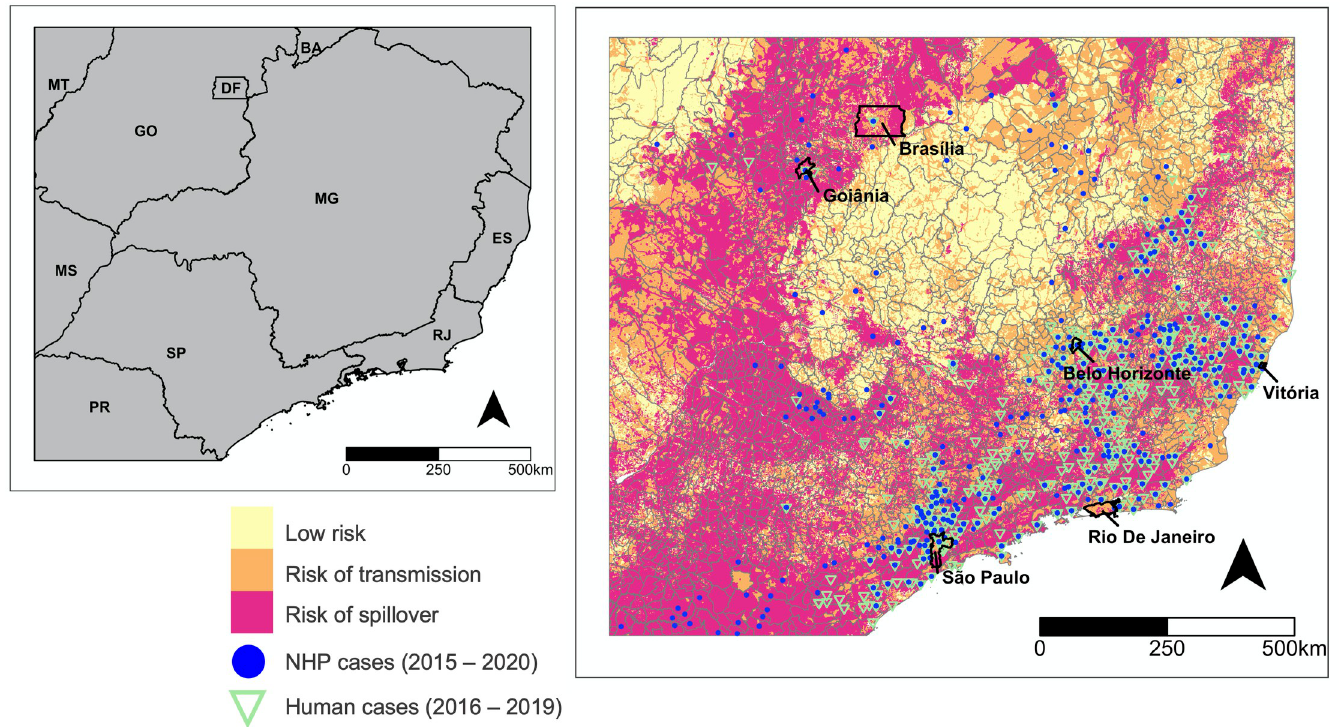
Fig 5. Risk of transmission and spillover along the Southeastern Atlantic Forest Biome. Map showing the distribution in risk status in the Southeastern municipalities of S ã o Paulo, Minas Gerais, Rio de Janeiro, Espı´rito Santo, and Southern state of Parana´ and adjacent municipalities in the Central-West, including the Federal District, Goia´s, and Mato Grosso. Risk is defined by the presence of sylvatic mosquito vectors, non-human primate reservoirs, and human population density. Low risk refers to the presence of only one of these factors. Risk of transmission is defined by the overlapping presence of two of these factors, while risk of spillover is defined by the overlapping presence of all three factors. Blue points show the locations of confirmed cases among non-human primates (NHP) recorded between years 2015–2020 while green triangles indicate the locations of confirmed human cases recorded between 2016–2019. The base layer of the map was retrieved from